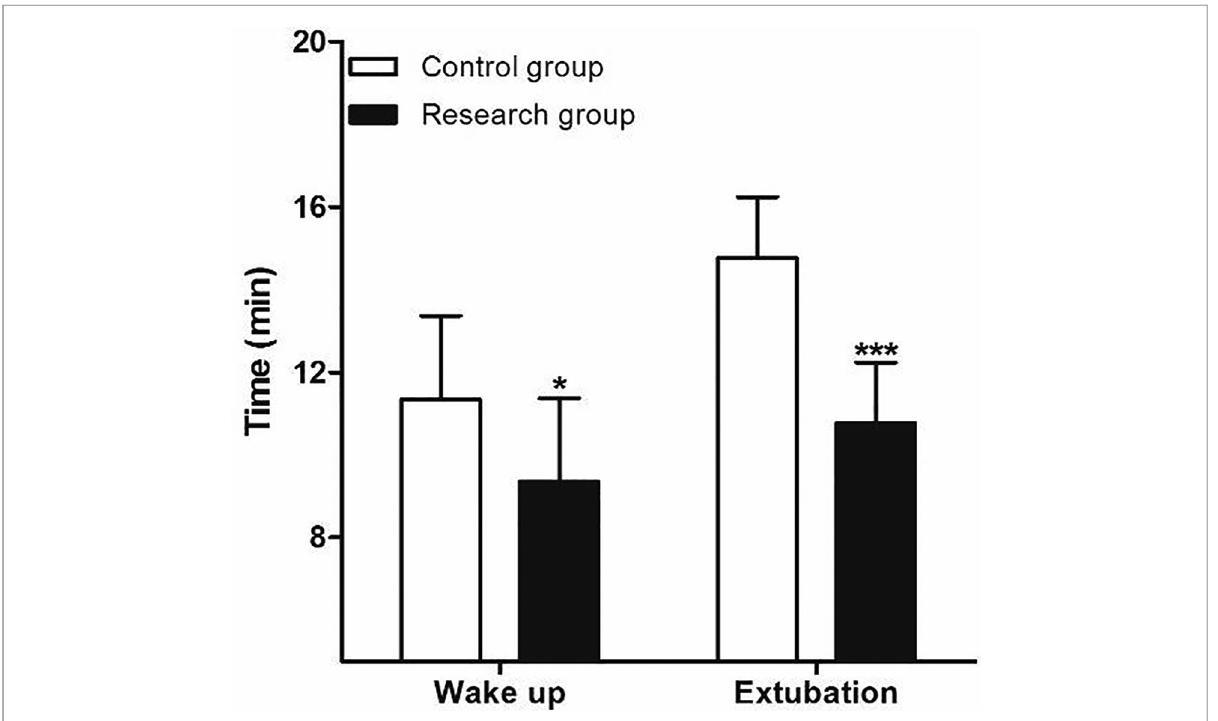
FIGURE 2 Comparison of postoperative the time of waken up and extubation between two group. Compared with Control group, * P <0.05 and *** P <0.001.